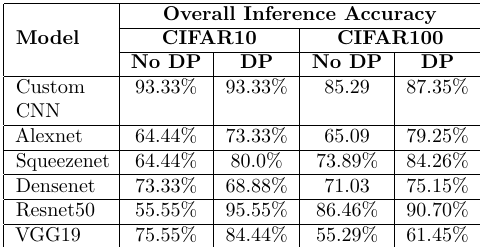
Table 3: Comparison of percentage of CI- FAR10 and CIFAR100 class pairs distinguish- able by different CNNs with and without dif- ferential